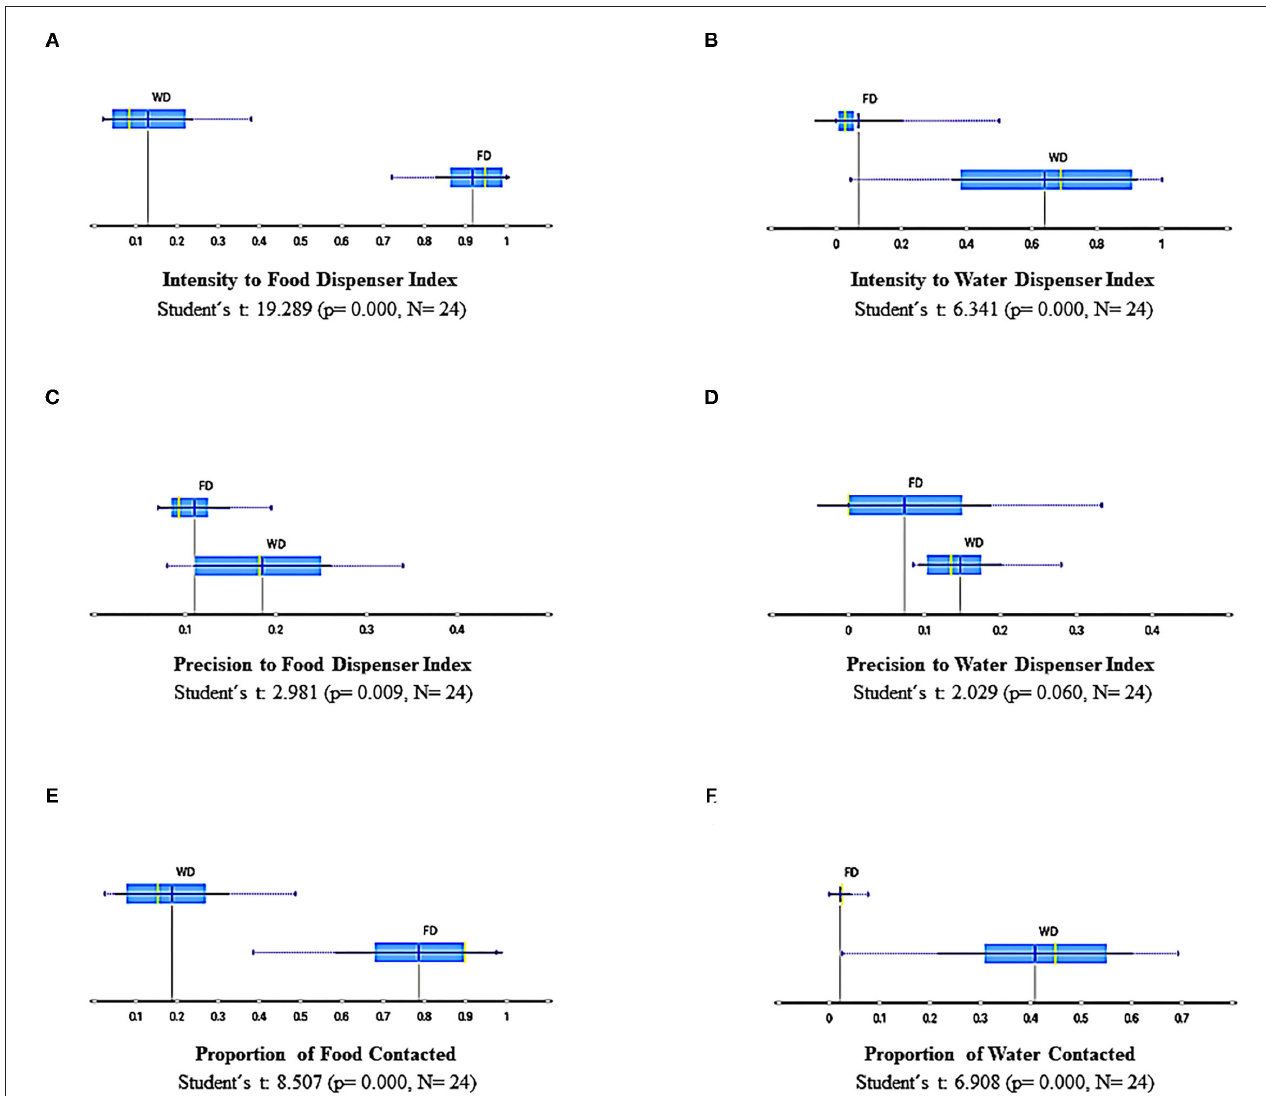
FIGURE 10 | Summary results of measures based on discrete responses for all sessions and subjects under FD and WD schedules: Intensity to food dispenser index (A) , intensity to water dispenser index (B) , Precision to food dispenser index (C) , Precision to water dispenser index (D) , Proportion of food contacted (E) , and Proportion of water contacted (F) . Each box depicts the mean (dark blue vertical line), the median (yellow vertical line), the standard deviation (thin blue line), and the values between the first and the third quartile (blue highlighted